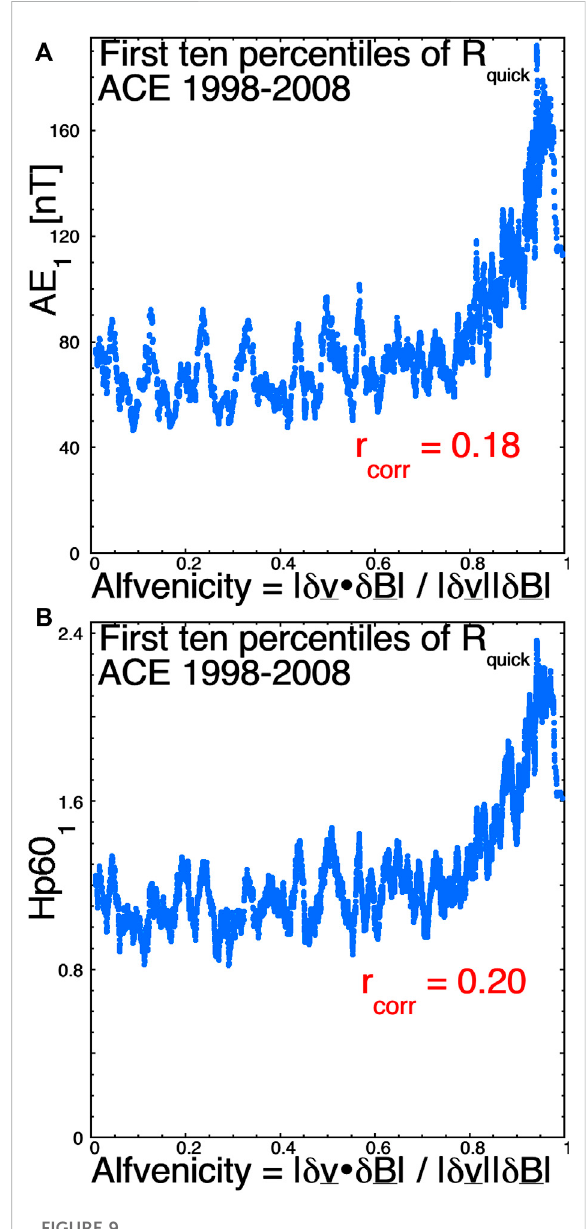
FIGURE 9 Fortimeswhenthesolar-winddriverR quick isinitslowest10% of values, 101-point running averages of AE 1 [panel (A) ] and of Hp60 1 [panel (B) ] are plotted as functions of the Alfvénicity